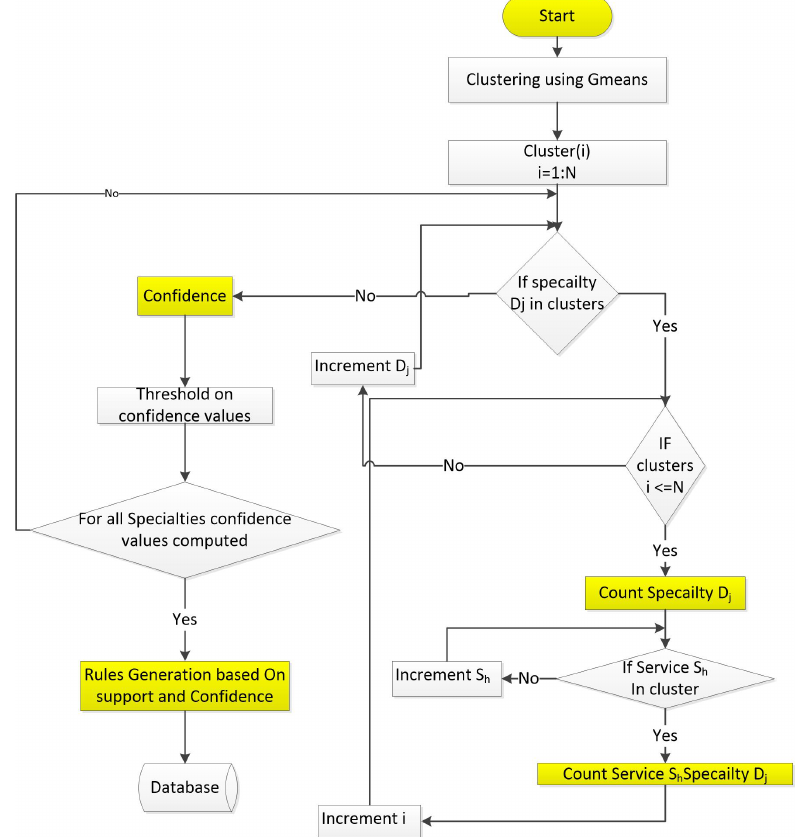
Figure 4. The rule engine is computing confidence values for all services in all